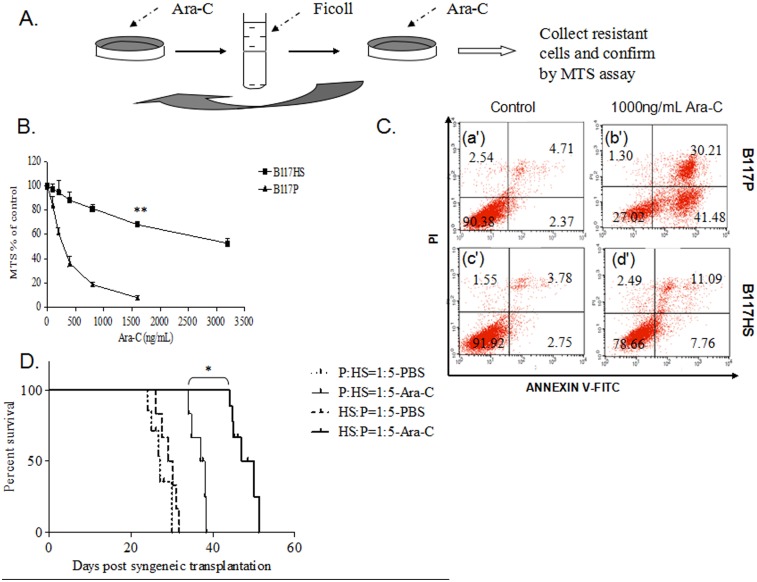
Sensitivity of leukemic cells to Ara-C determined the survival of treated AML mice.Fig. 4A) Selection scheme for generation of Ara-C resistant AML cells (B117HS). Fig. 4B) Comparision of B117P with B117HS in their sensitivities to Ara-C by MTS assay. **p<0.01. Fig. 4C) B117P or B117HS treated either with cell culture medium (a’ and c’) as control or with 1000 ng/mL Ara-C for 48 hours (b’ and d’) were subjected to flow cytometry analysis, according to the Methods. Fig. 4D) Survival of B6C3F1 mice transplanted with 2×105 leukemic cells containing different proportions of B117P and B117HS cells, followed by the treatment with Ara-C or PBS control. Each group included 12 B6C3F1 mice. *p<0.05.